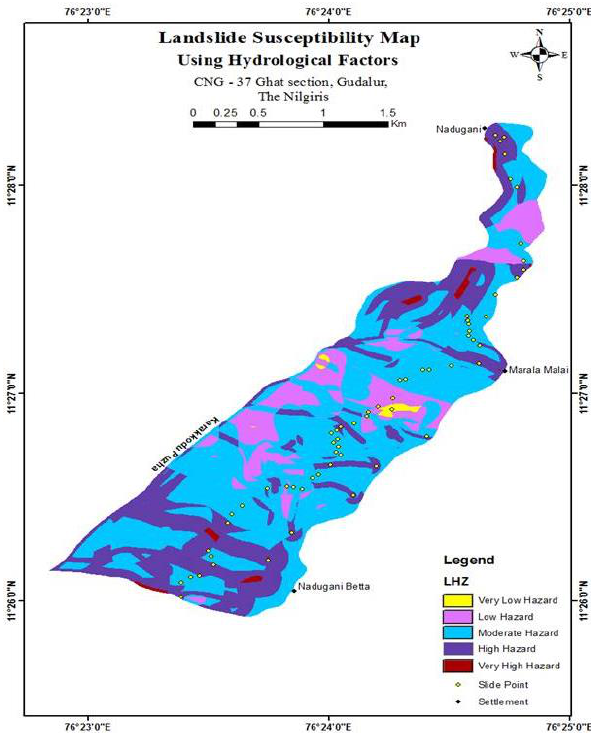
Figure 5 LSZ map using hydrological factors